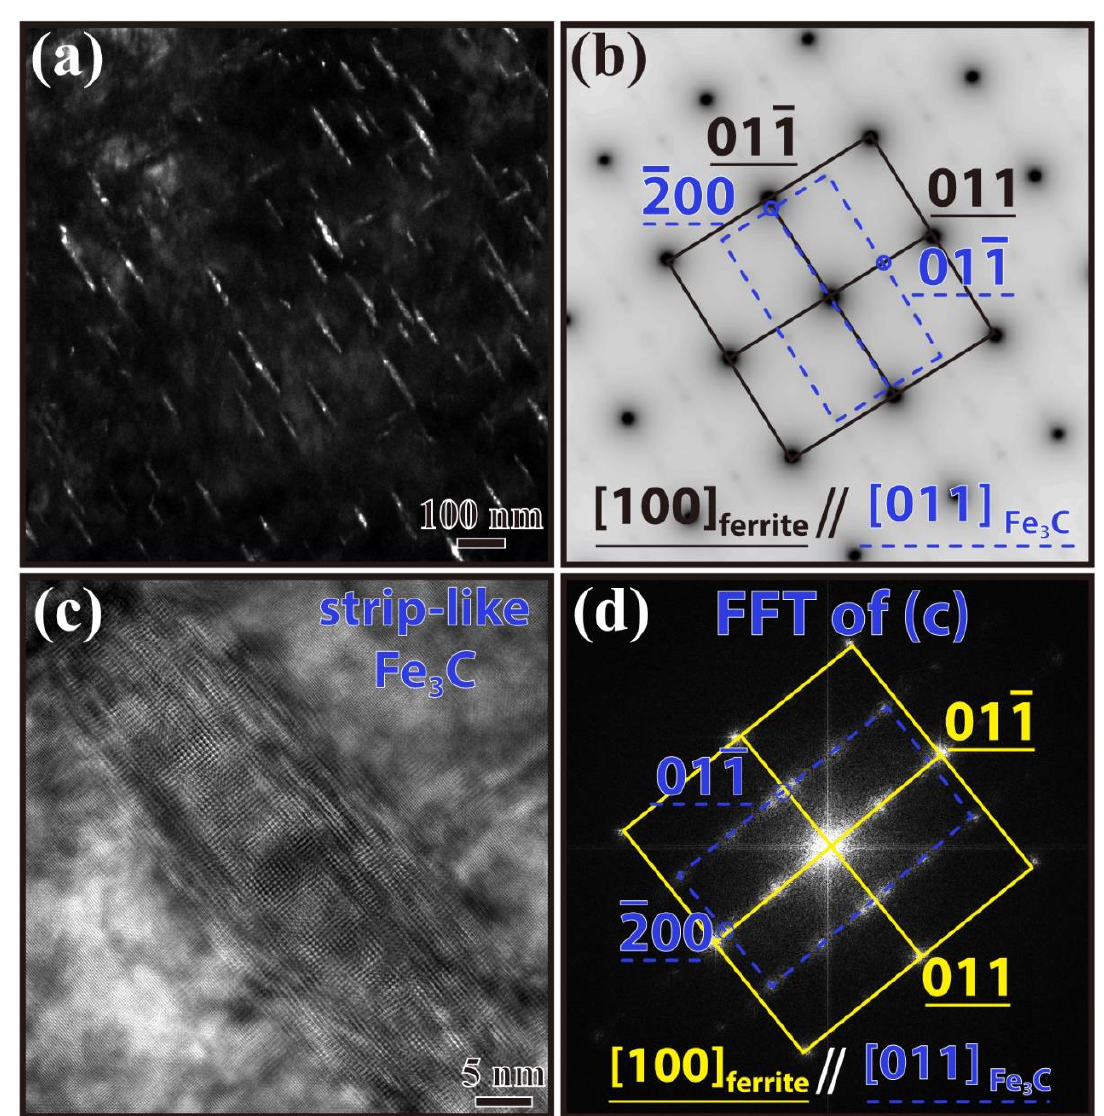
Figure 5. ( a ) TEM bright-field image of a spherical niobium precipitate. ( b ) Corresponding energy- dispersive X-ray spectroscopy (EDS).